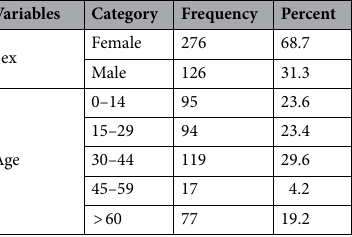
Table 1. Socio-demographic characteristics of sample source patients for ceftriaxone